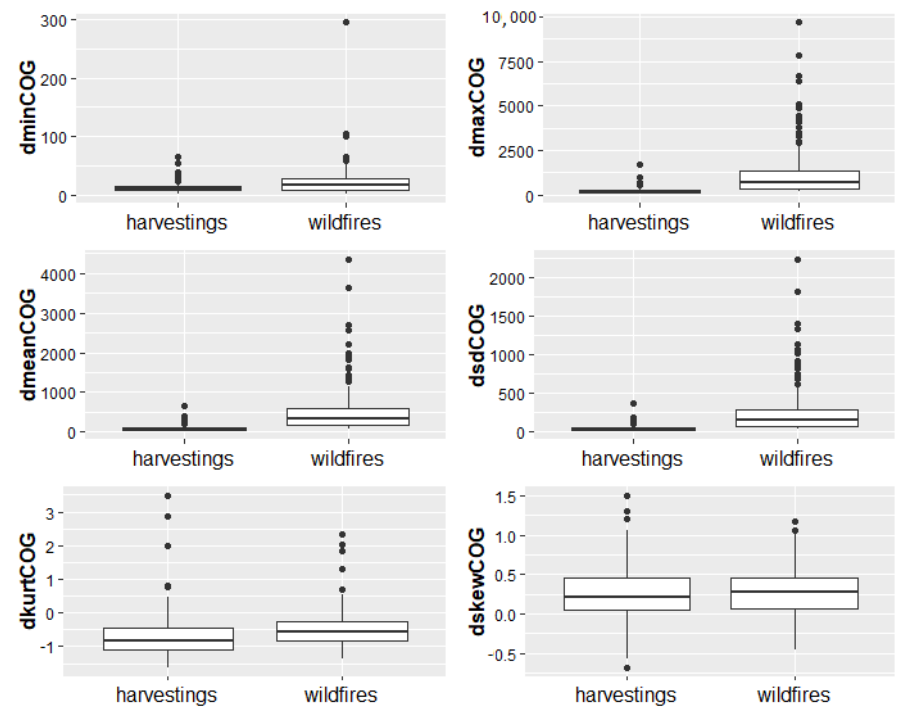
Figure 7. Paired boxplots of the metrics calculated related to the distance from each point in the cluster to the center of gravity of the cluster. Boxplots are median based.